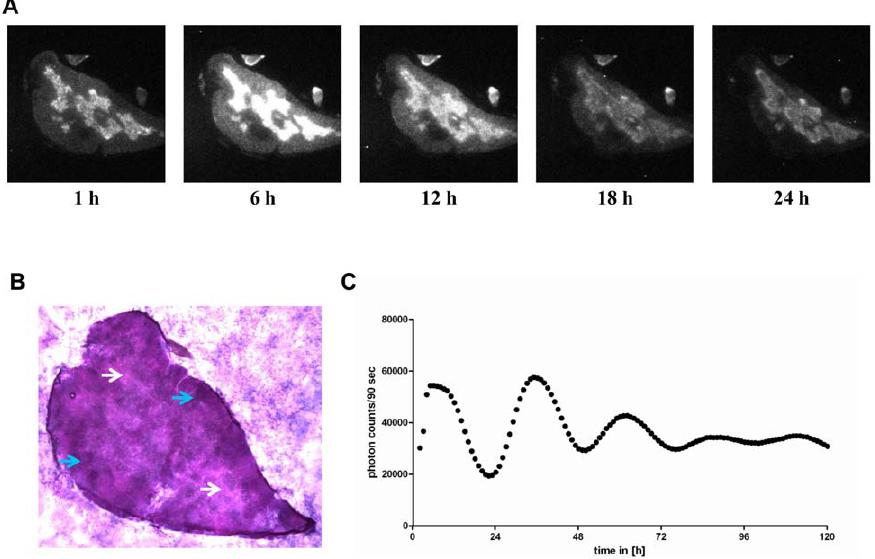
Figure 1. Bioluminescence microscopy of PER2::LUCIFERASE thymic sections. Male PER2::LUCIFERASE reporter mice were sacrificed and the thymus lobe was sliced. One section was put into medium (DMEM) supplemented with luciferin and light emission was continuously imaged (10-fold magnification applying the Olympus LV200) over approximately five days at 37 u C. A) Depicted are microscopic images in six hour intervals of the first 24 h (the complete microscopic video is in the supplemental material). B) A section of the in A analyzed thymus lobe was stained with haemalaun/ eosin to visualize cortex and medulla of the thymus lobe (2.5-fold magnification). White arrows show the medulla (light purple regions) and blue arrows show the cortex (dark purple regions). C) Shows the quantified amount of light emission by the thymic slice over the whole recording time. Shown are data of one out of two experiments (period length=26 h).